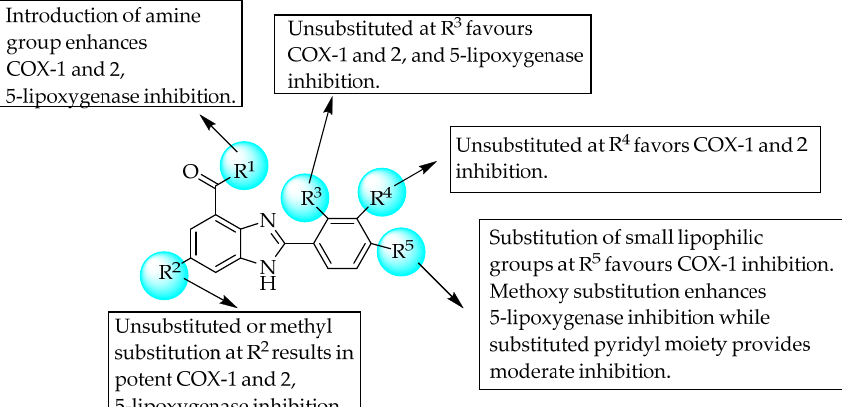
Figure 7. SARs of 2-phenyl-substituted benzimidazoles.